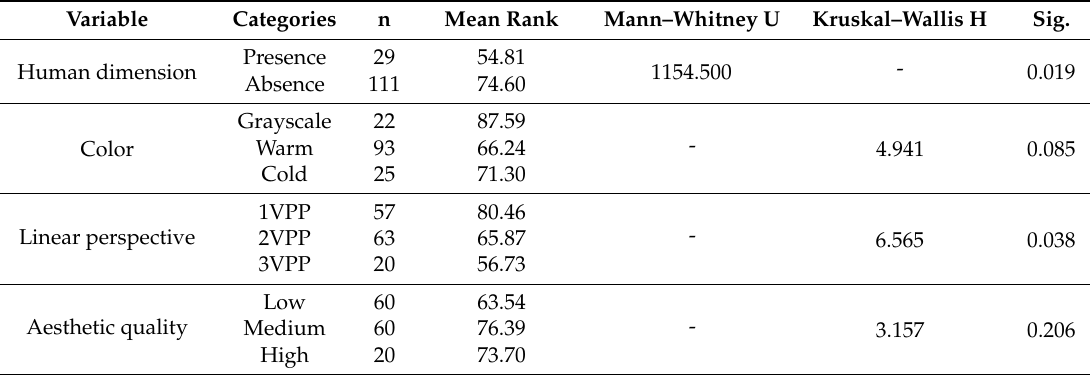
Table 4. Non-parametric test results (dependent variable: engagement).